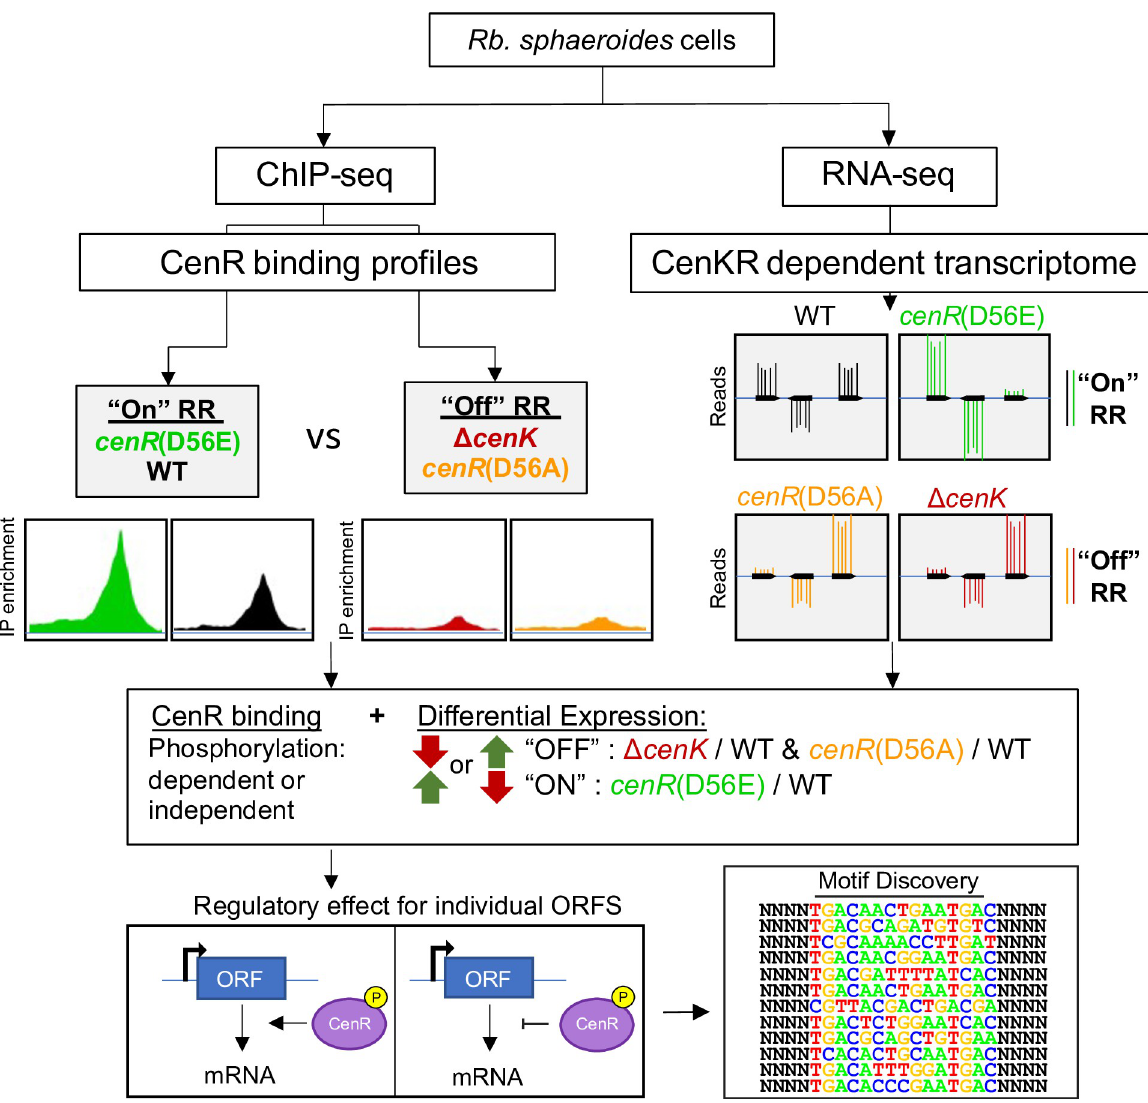
Fig 3. Strategy used to define members of the CenKR regulon. The in vivo genome-wide CenR binding sites and CenKR-dependent transcriptomic data were generated from strains with a hyperactive (CenR D56E), wild-type (WT), and low activity (CenR D56A and Δ CenK) TCS. Combined data sets were used to identify genes directly regulated by CenR and the mode of regulation of each candidate gene. Genomic CenR binding sites were then analyzed for a putative DNA binding motif recognized by CenR to further refine the predicted CenR regulon.